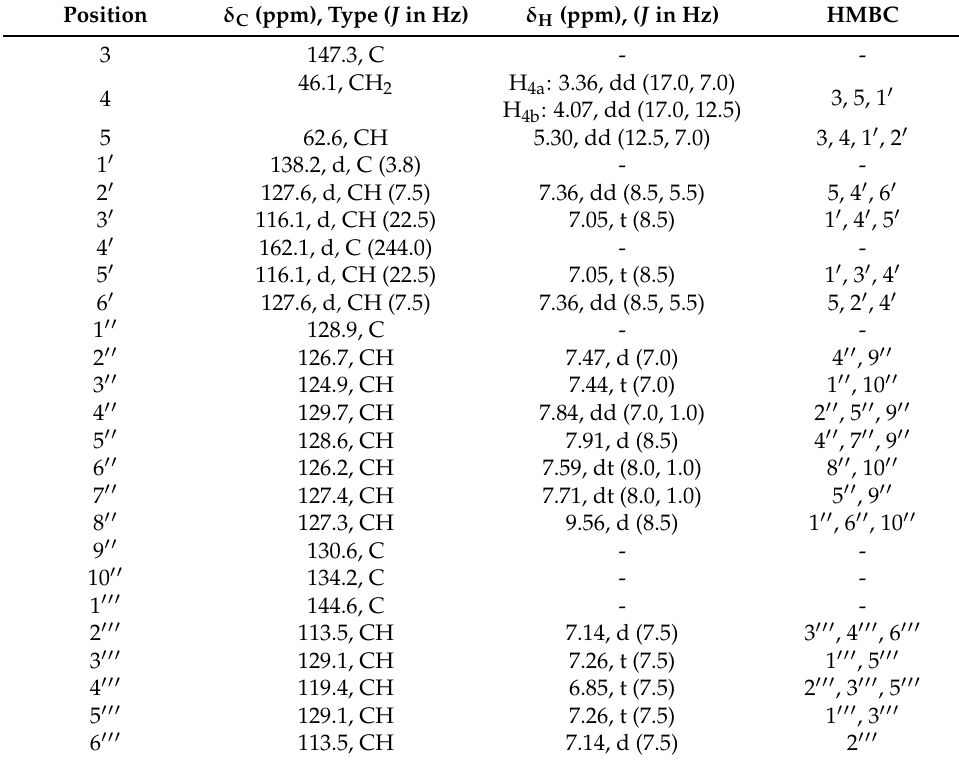
Table 1. NMR Spectroscopic Data (500 MHz for 1 H and 125 Hz for 13 C in CDCl 3 ) for 4 . Position δ C (ppm), Type ( J in Hz) δ H (ppm), ( J in Hz) HMBC 147.3,